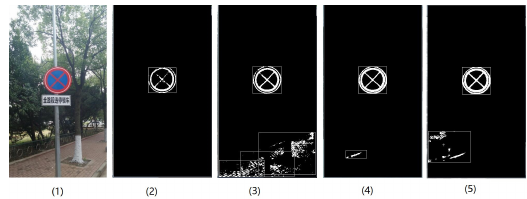
Figure 17: Results Obtained By Different Color Space In Normal Light